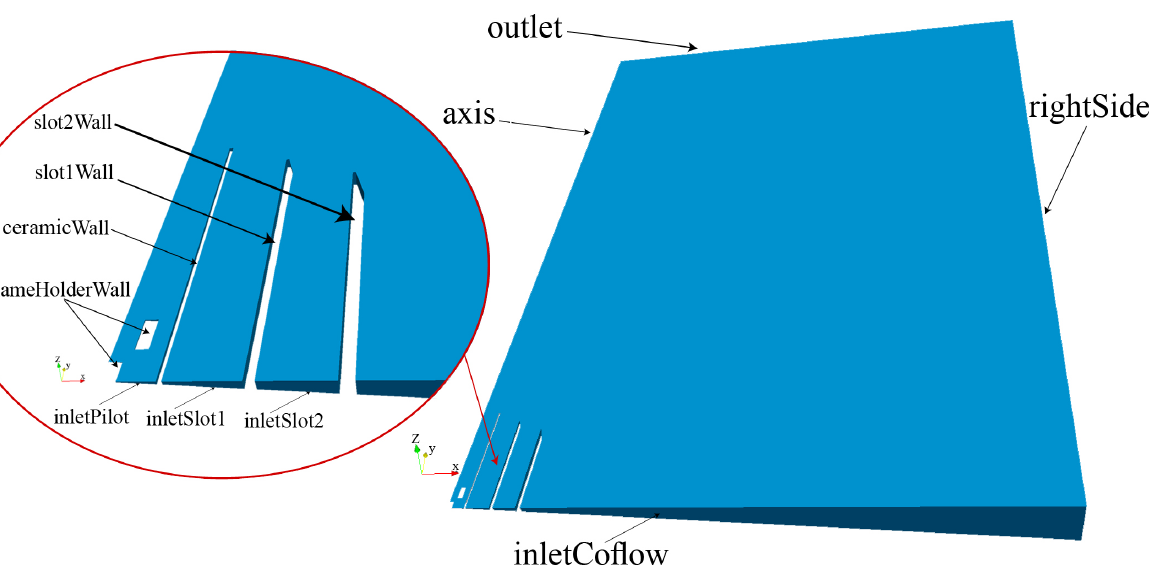
Figure 3. 3-D axisymmetric wedge domain for the numerical investigation of the Darmstadt TSF